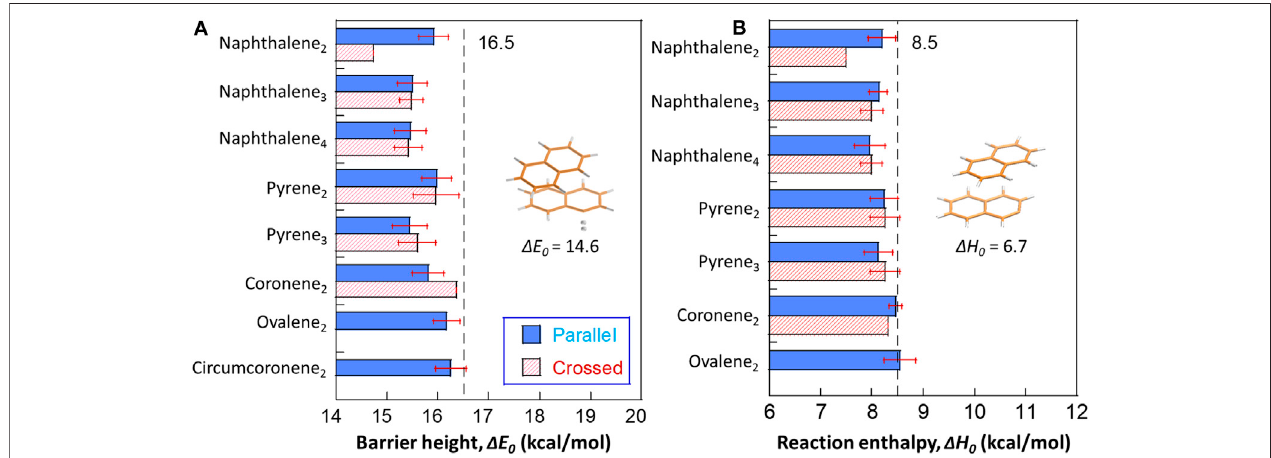
FIGURE 3 | The barrier heights (A) and reaction energies (B) for hydrogen abstraction from small PAH clusters by H radicals. The transition state of a naphthalene dimer with the lowest barrier height among all optimized con fi gurations is highlighted in Figure 3A . The structure showing the least reaction enthalpy for H abstraction reactionisincluded in Figure3B .Thedashed linesrefertotheaveragebarrierheightsand reactionenergiesofoptimized monomersattheM06-2X/6-311G(d,p)levelof theory as 16.5 and 8.5 kcal/mol, respectively. The red error bars refer to one standard deviation from the results on different sites within the particular case.